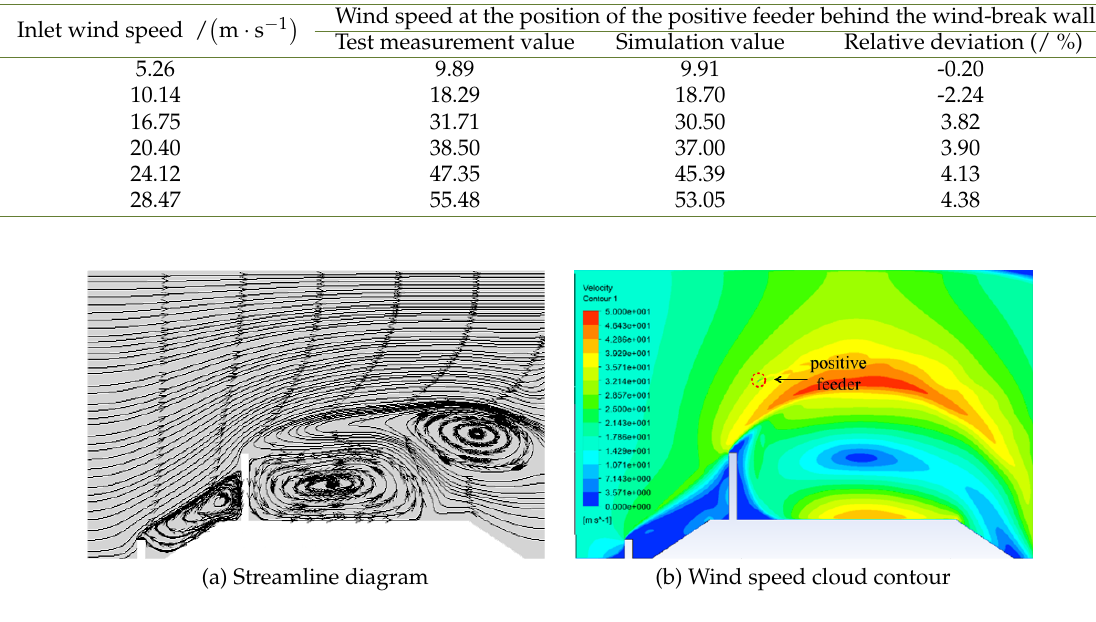
Fig. 11. Flow field diagram of calculation domain with double wind-break walls